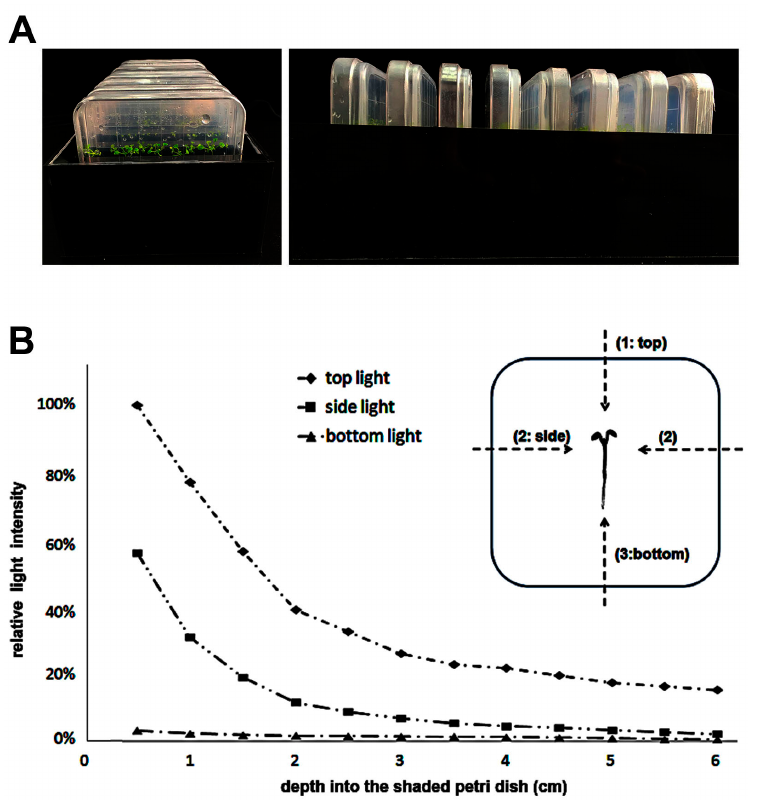
Figure 1. Relative light intensity in the shaded Petri dishes in the IPG growth condition. ( A ) Petri